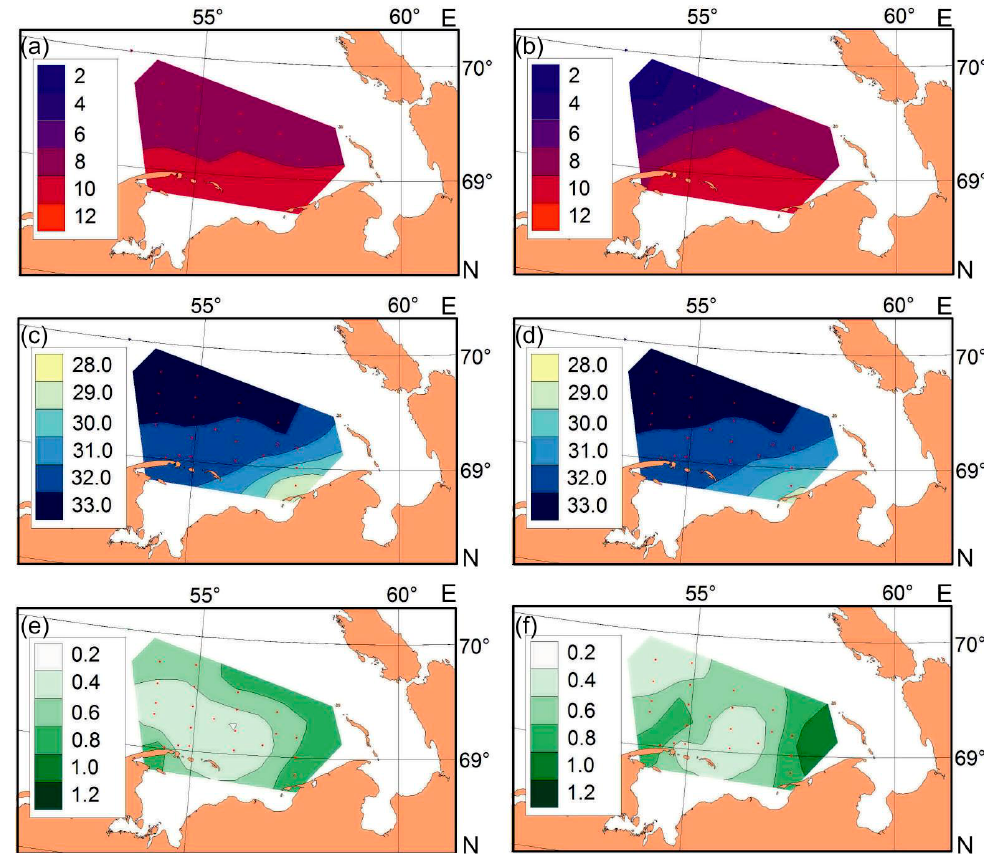
Figure 2. Distribution of surface ( a ) and mean ( b ) temperature (°C), surface ( c ) and mean ( d ) salinity, surface ( e ) and mean ( f ) chlorophyll a concentration (mg m –3 ) in the south-eastern Barents Sea in summer 2012.